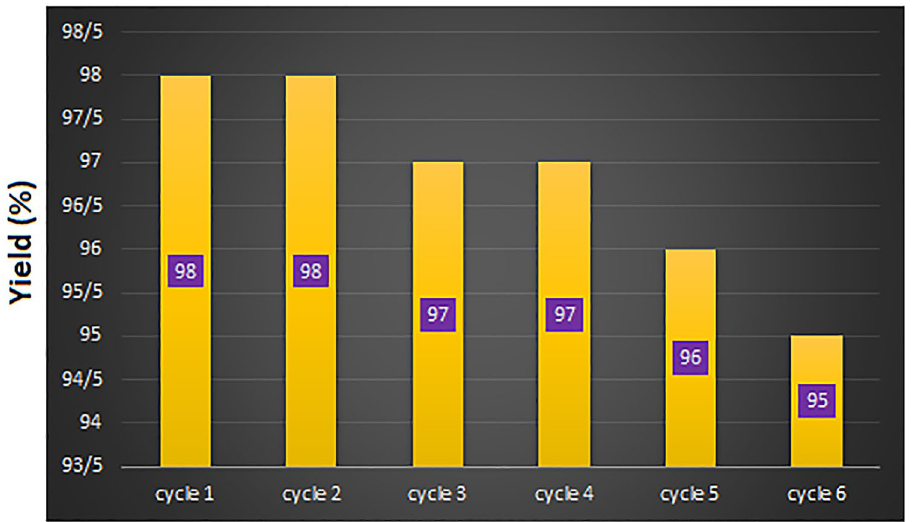
Figure 12. Recycling of Fe 3 O 4 @SiO 2 -PMA-Cu in the synthesis of 2-phenyl-2-(4-phenyl-1 H -1,2,3-triazol-1-yl) ethane-1-thiol.